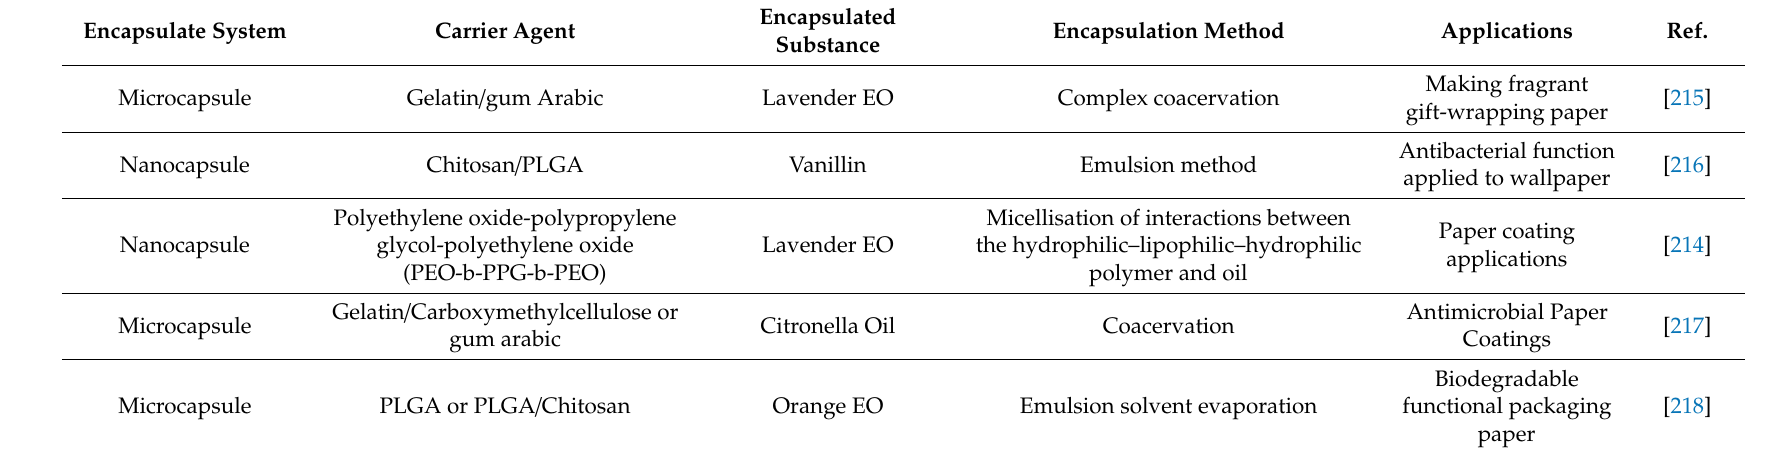
Table 4. Recent studies reporting the micro / nanoencapsulation of fragrances and flavours for paper